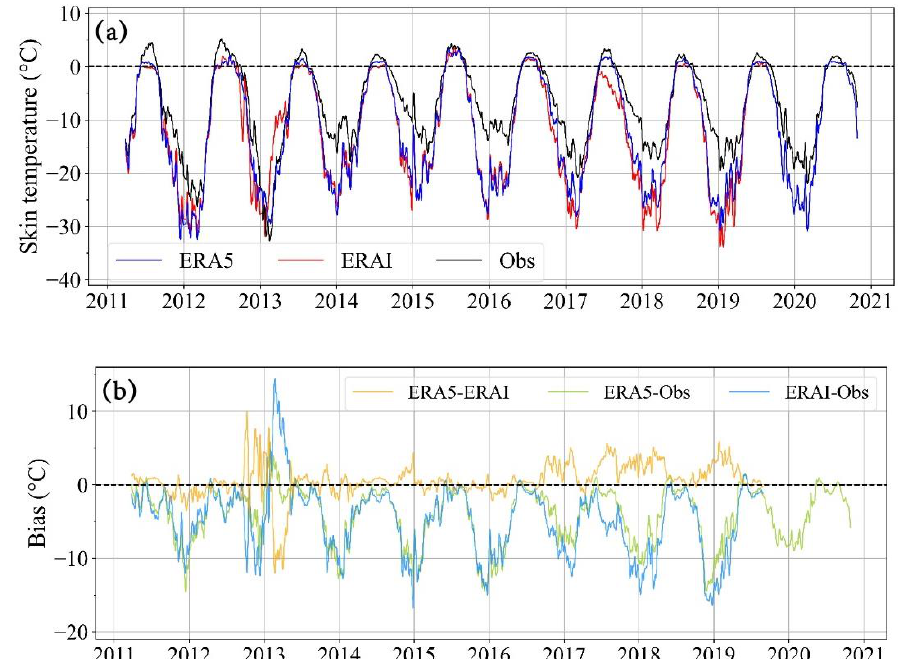
Figure 6. The time series of ( a ) the daily mean Ts from ERA5, ERA-I, and buoy observations and ( b ) the biases between ERA5, ERA-I, and the buoy observations averaged from all of the buoys trajectories during 2011–2020. Seven-day smoothing was applied to the time series shown here. A total of 3060 and 3487 matching pairs for ERA-I and ERA5, respectively, were used for the comparisons of the daily mean Ts (Figure 7a,b). Based on the scatter plots, both reanalysis methods exhibited significant cold biases, and the biases were larger when the surface temperature was low. Furthermore, as shown in Table 4, if the 10 ◦ C temperature intervals are considered, the ERA-I was closer to the buoy observations in the cold environments (lower than − 20 ◦ C), while the ERA5 performed better in the − 10–0 ◦ C and 0–10 ◦ C intervals.